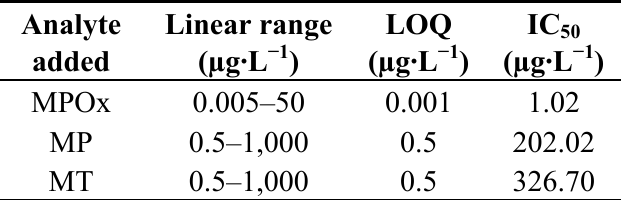
Table 2. Analytical figures of merit for the developed bioassay in spiked